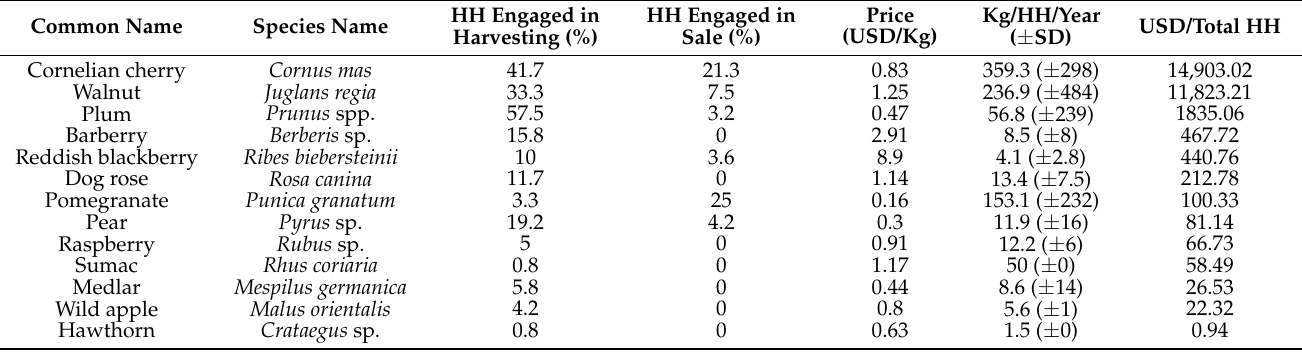
Table 1. Quantities and incomes from different fruit-providing species by households (HH) in Arasbaran forests,